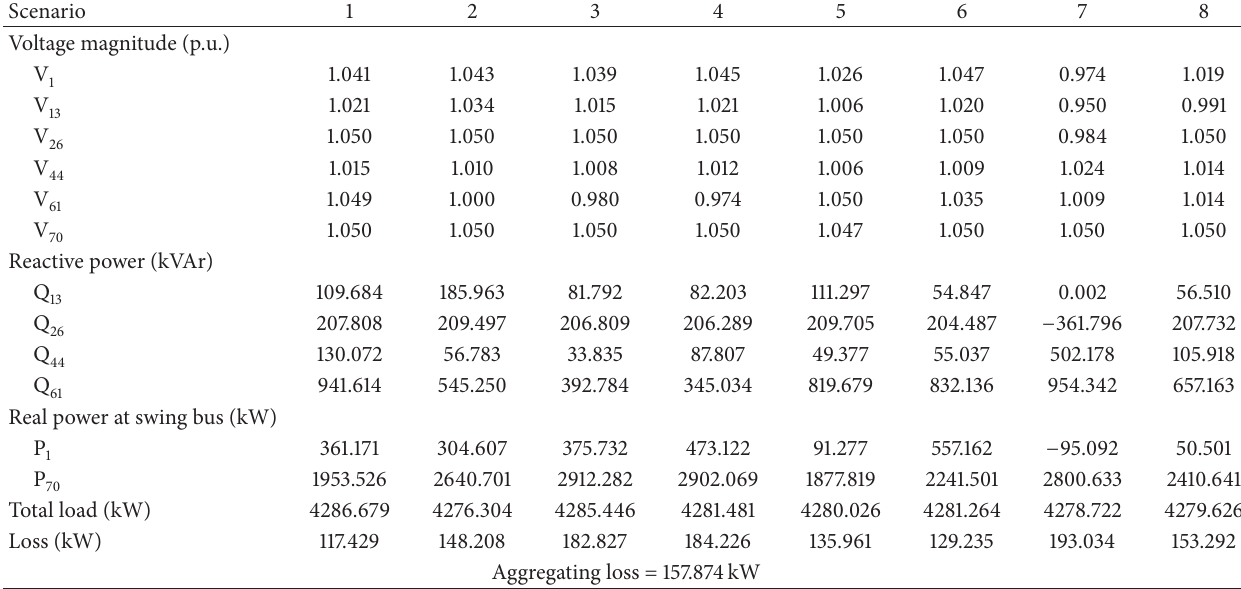
Table 4: Optimal results before feeder reconfiguration.